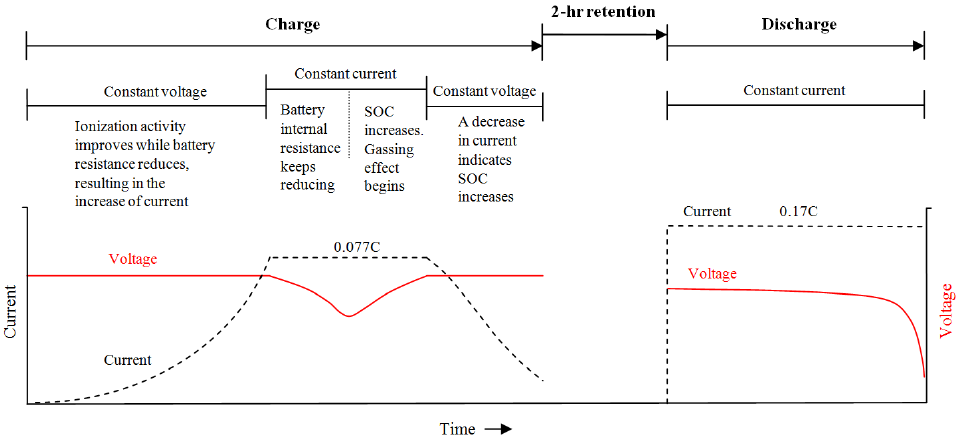
Figure 2. Charging and discharging procedures for case two and case